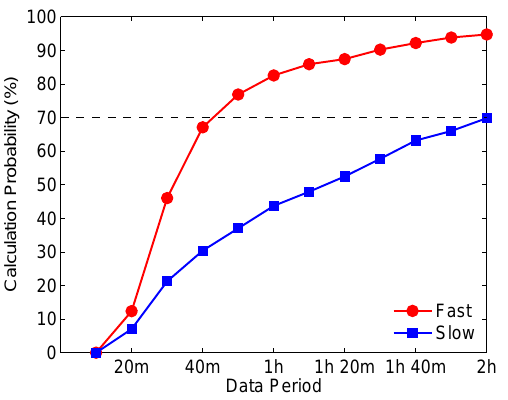
Fig. 4. Offset calculation probabilities for fast and slow solar wind from 1976, Helios 2 (specific dates in Table 1).